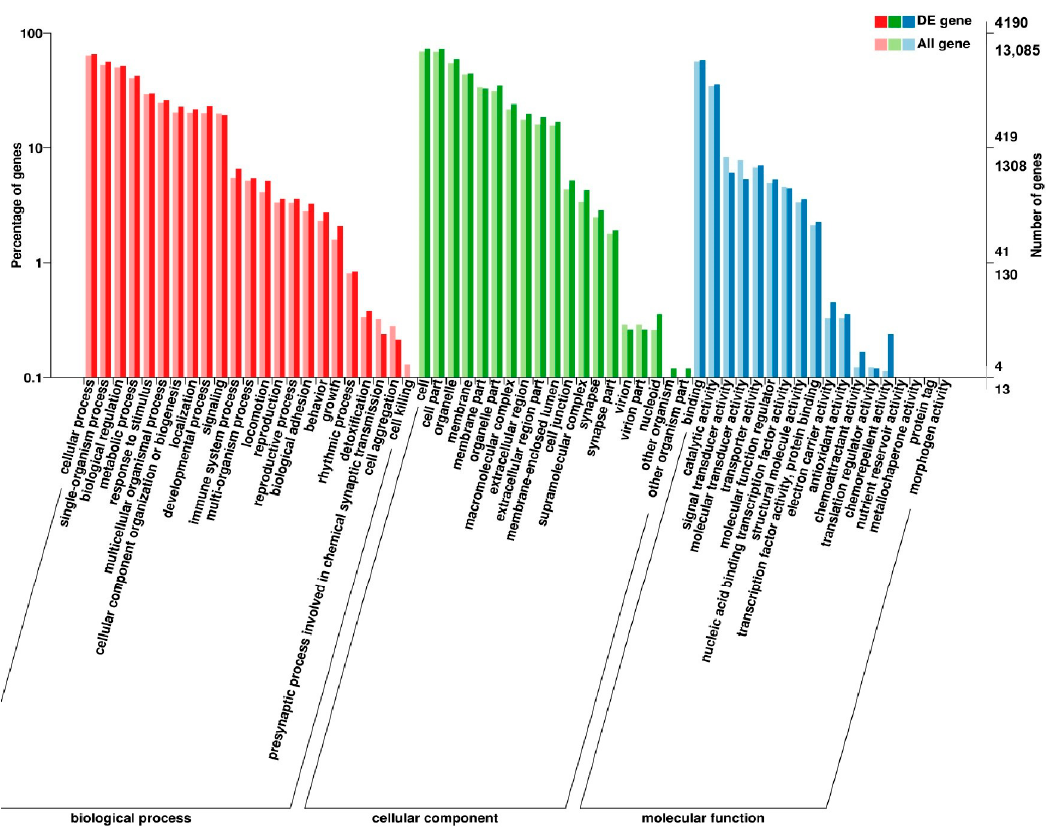
Figure 5. GO enrichment analysis of DEGs in breast muscle of